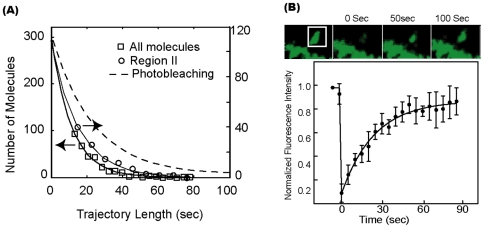
Kinetic dynamics of F-actin in dendritic spines.(A) Distributions of the lengths of single-molecule tracks from dendritic spines. The solid line is the single exponential fit. The dashed line is the expected distribution from only photo-bleaching. The distribution for the subpopulation excluding stationary filaments is also plotted as comparison. (B) FRAP measurements in dendritic spines. Top images show bleaching and recovery of a spine. The bottom graph shows the average normalized fluorescence intensity of 10 spines measured. Errorbars represent standard deviation. The solid line is the fit with single exponential recovery.